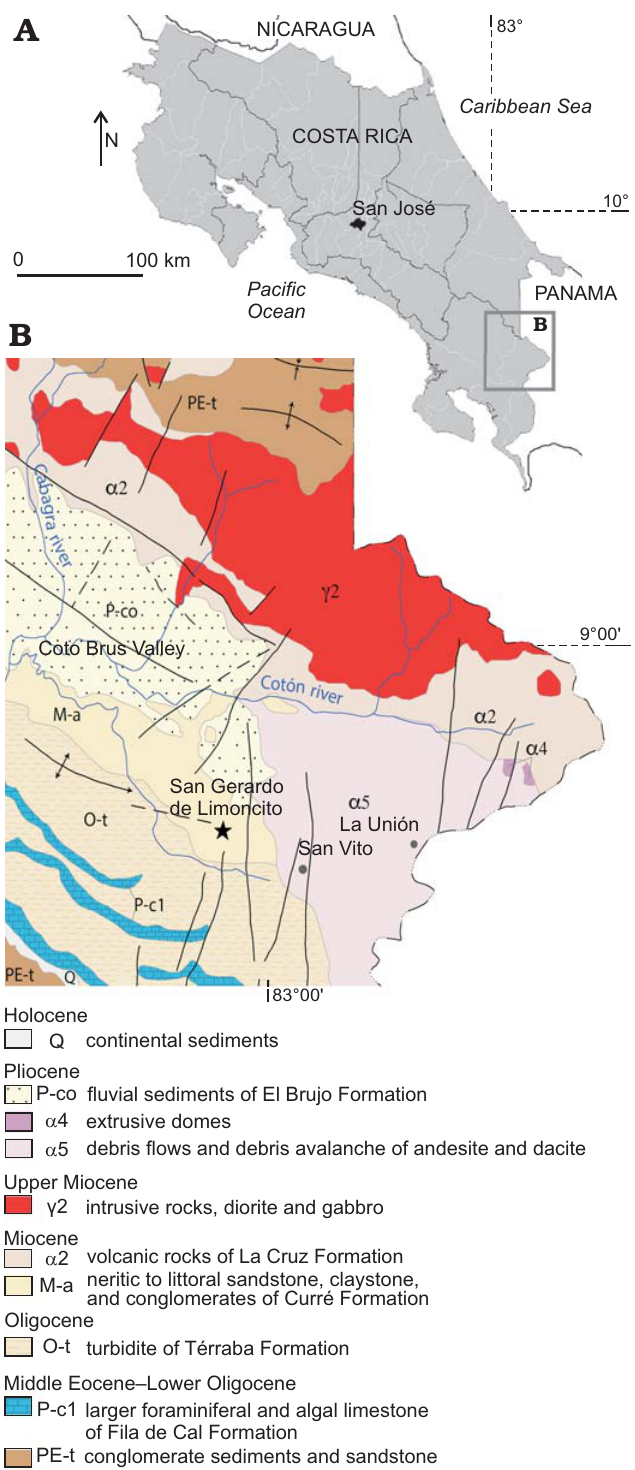
Fig. 1. A . Geographic location of studied area. B . Geological map of the San Gerardo de Limoncito area, modified from Denyer and Alvarado (2007).